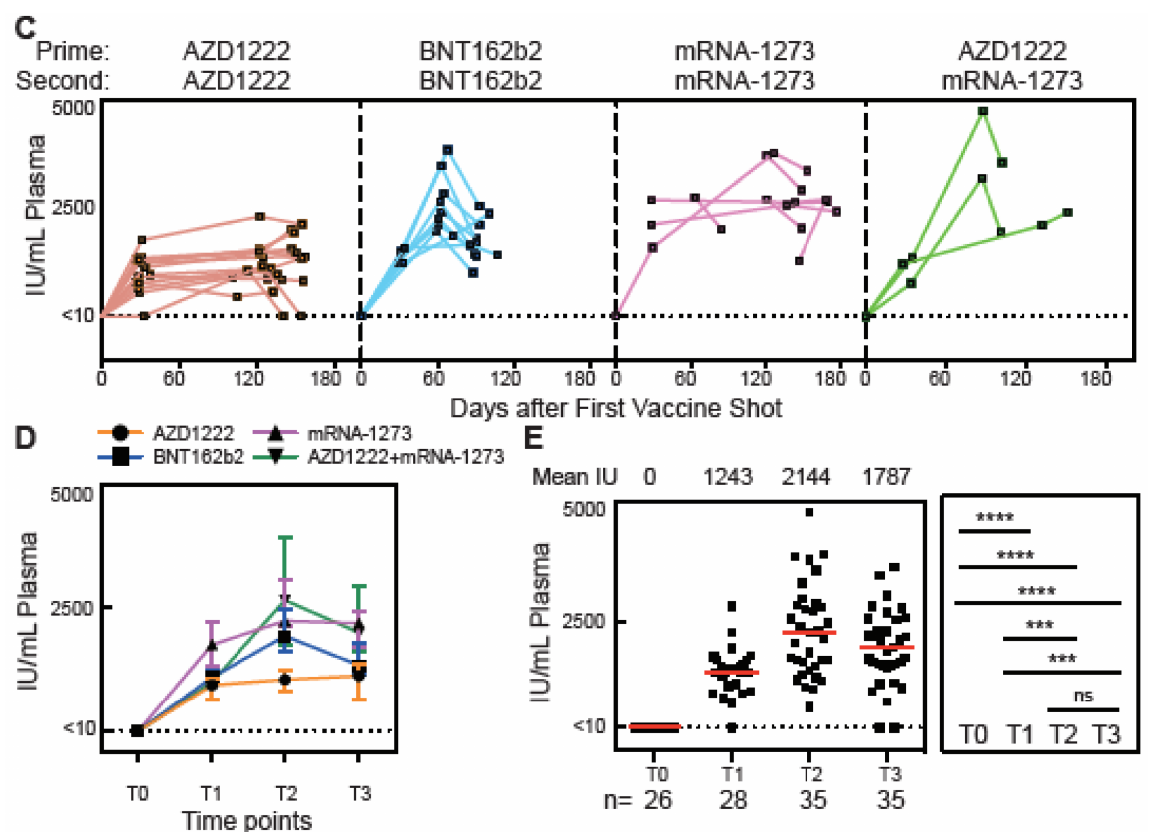
Figure 1. Neutralizing antibody responses before and after vaccination in SARS-CoV-2 naïve subjects. ( A ) Timeline for blood draws for analysis of nAbs in plasma, the secretion from stimulated PBMCs, or cellular identification with the MiSelect R II. T0 is defined as being shortly before vaccination, T1 is 4 weeks after the first vaccine dose, T2 is 4 weeks after the second dose, and T3 is 8 weeks after the second dose. The time interval between the first dose and the second dose varied from approximately three months to just one month. ( B – D ) Concentration of neutralizing anti-spike-RBD IgG antibodies in plasma samples from vaccinated subjects over time. ( E ) Total neutralizing anti-spike-RBD IgG concentrations and mean number in plasma sample from all vaccinated subjects (n) for each time point. IU is international units. The error bar indicates the median and interquartile range. Statistics were calculated using the non-parametric Mann–Whitney test. The dotted line indicated the limit of detection (LOD) for the assay.; *** p < 0.001; **** p < 0.0001; ns, no significant